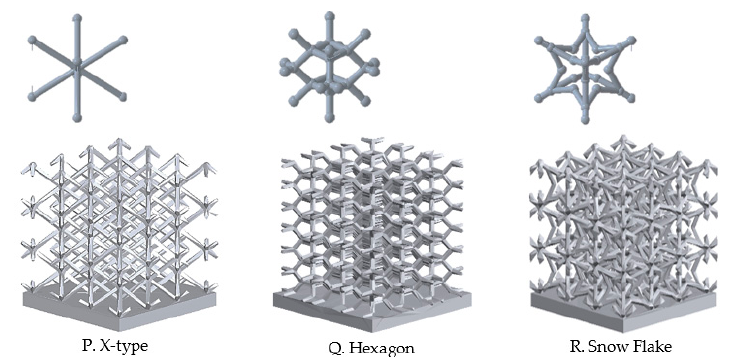
Figure 6. Different lattice heat sinks models.